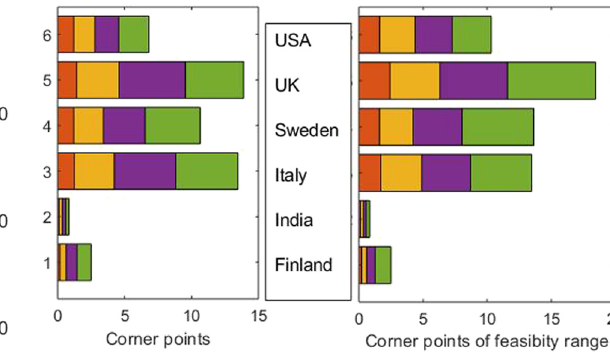
Figure 10: Parameters ( ) x min j , ( ) c l j . c j , ( ) c h j , and ( ) x max j for the daily new con fi rmed deaths: fi rst 240 days ( left ) and all data ( right ) .